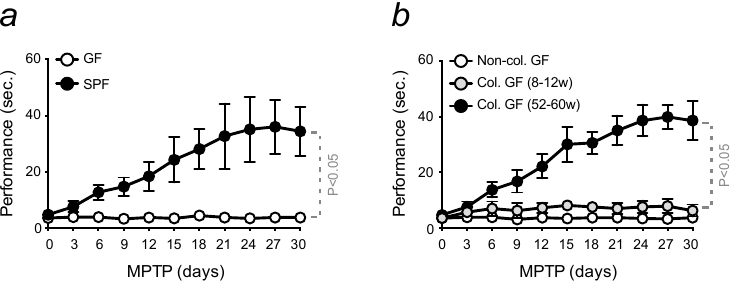
Figure 1. Age-related dysbiosis primes the development of PD. All mice are in C57BL/6 background ( a ) conventional (SPF) 8–12 weeks old (young) mice, and aged-matched GF animals were intoxicated with MPTP (20 mg/kg, i.p., 4 injections 2 h apart). Motor dysfunction was evaluated by assessing the time of performance on a pole test. Mice were monitored for 30 days after MPTP administration. ( b ) Motor performance of GF mice colonized or not (Ctrl) with stool samples collected from conventional young or 52–60 weeks old (old) mice, treated as in ( a ). The results are expressed as mean ± SD ( n = 7–10 mice per group). Statistical analysis was performed by applying the one-way ANOVA test.